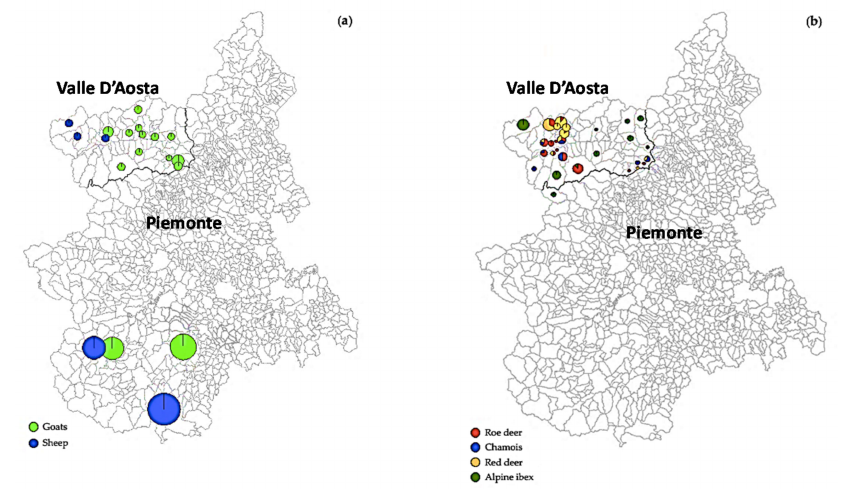
Figure 1. Mapping of sheep and goat farms ( a ) investigated and sites ( b ) in which wild ruminants were